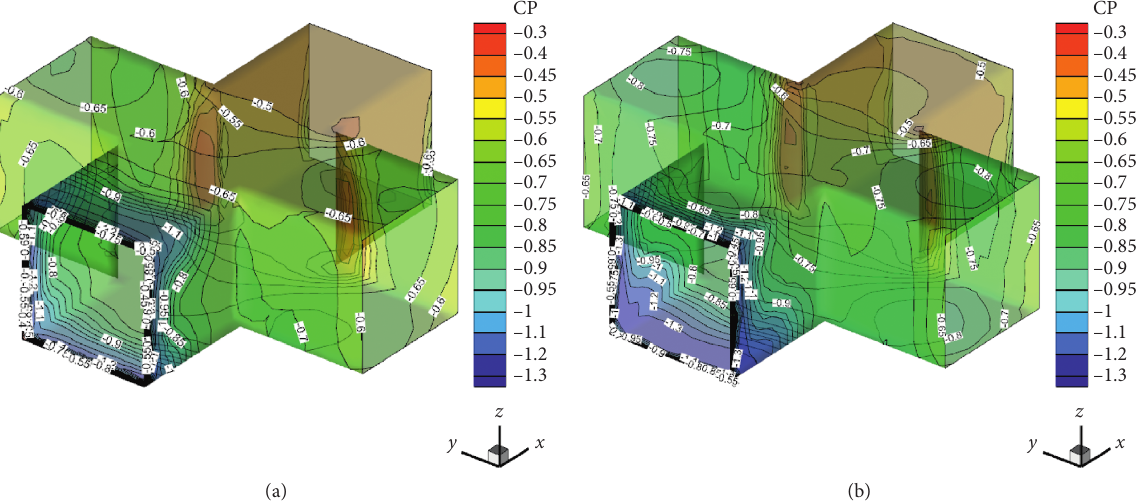
Figure 6: Mean wind pressure distribution in the openings of L-3 model. (a) Upper opening. (b) Lower